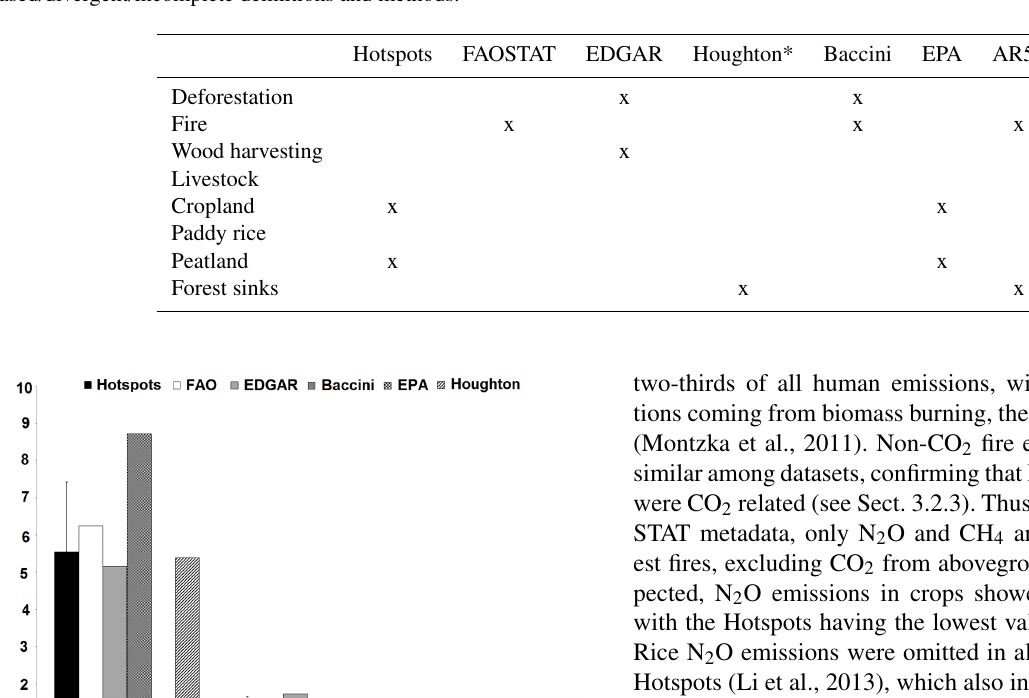
Table 4. Identification of the least reliable emission source (x) for each dataset considering disagreements among emission estimates due to biased/divergent/incomplete definitions and methods.